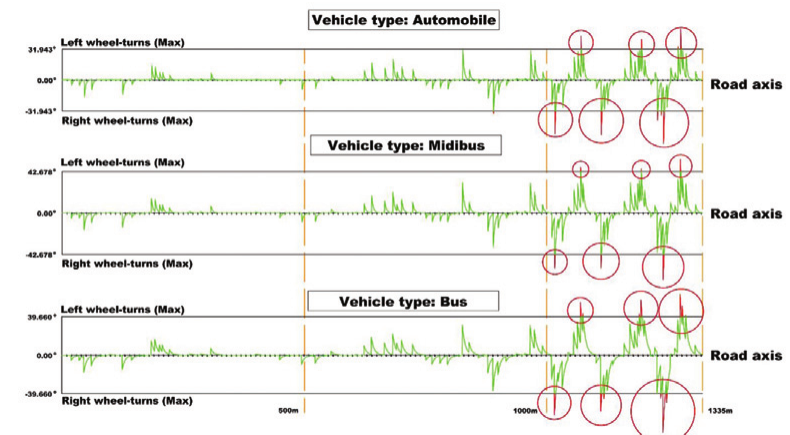
Fig. 8. Graphical report pertaining to wheel turning angles for different vehicle